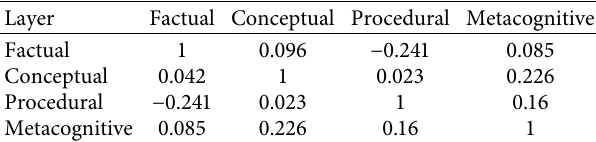
Table 6: Interlayer assortativity: Spearman’s correlation